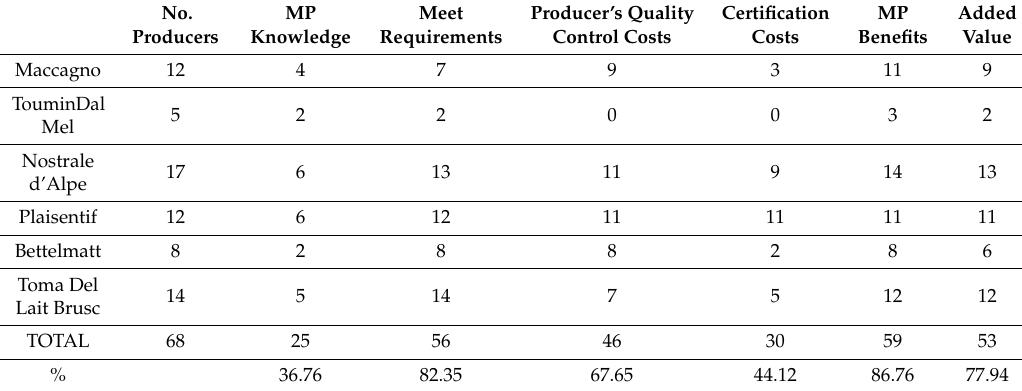
Table 2. Knowledge of and use of the term “mountain product” (MP), i.e., know-how on Optional Quality Term (OQT), ability to meet MP requirements and to sustain the quality control costs, willingness to pay certification costs, perception of added value of product and benefits of the use of the OQT “mountain product”.